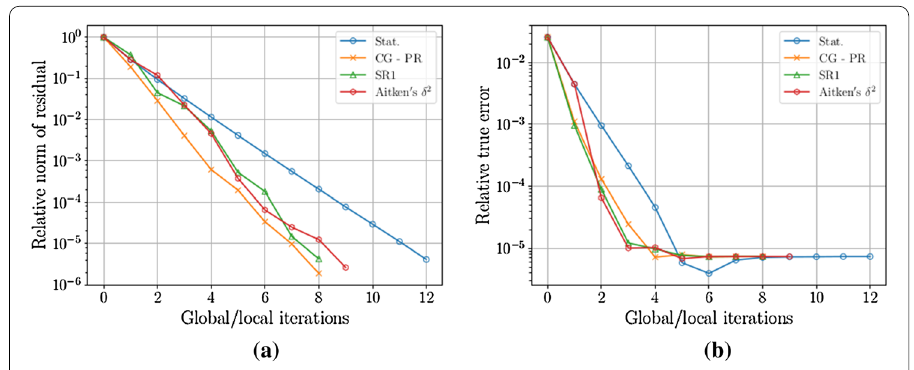
Fig. 7 Convergence in the full nonlinear case. a Evolution of the residual. b Mises stress error wrt Reference on the most loaded